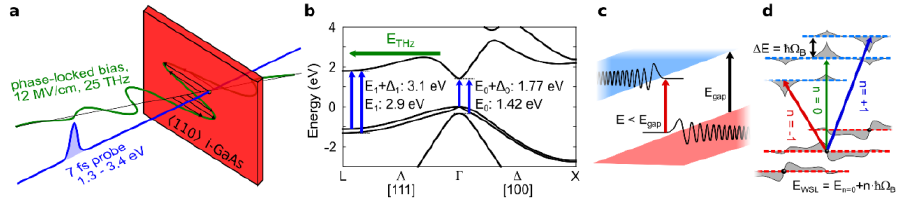
Fig. 1. (a) Measurement scheme: 400-nm-thick intrinsic GaAs grown in <110>-direction is biased by phase-stable mid-infrared transients with 25 THz center frequency and up to 12 MV/cm field strength. 7-fs probe pulses with 1.3-3.4 eV photon energy are used to probe the transmission with sub-cylce resolution. (b) Electronic band structure of bulk GaAs. Green arrow indicates the bias field in [111] direction, blue arrows show electronic transitions which are important for the experiment. (c) Sketch of the Franz-Keldysh effect: the bandstructure is tilted by an electric field. Electron wave functions reaching into the band gap create new optical absorption channels below the band gap. (d) Sketch of WSL: extreme electric fields lead to a localization of the electronc wave functions.